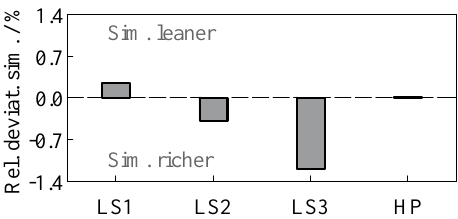
Figure 5. Relative deviation between simulation average λ and measured λ (according to Spindt